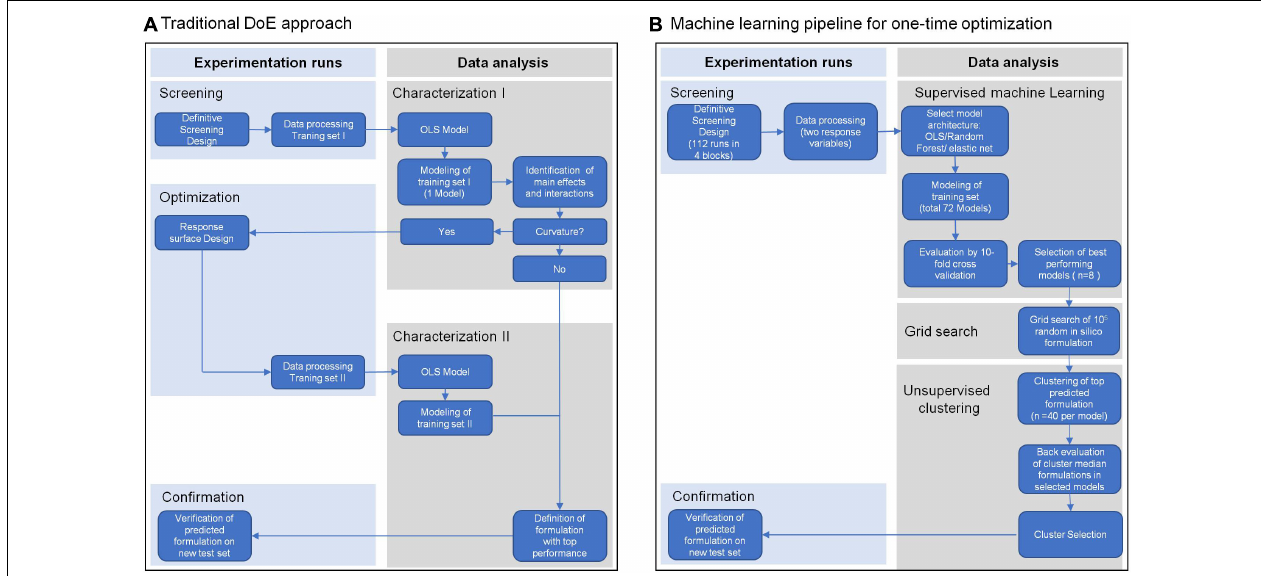
FIGURE 1 | Overview of the traditional Design of Experiment (DoE) approach (A) and of a machine learning pipeline (B) . Both approaches include a screening step for data collection, in this case from expansion of T cells from four different healthy donors in a definitive screening design. Traditional DoE uses interpretable model architectures across all donors such as ordinary least squares regression (OLS) to select significant features (Characterization I). A second experimental step is applied to screen for optimal parameter levels (Optimization II). In a second modeling step using OLS the optimal parameter levels are determined for an optimal media formulation (Characterization II) that is experimentally confirmed (Confirmation). The machine learning pipeline (B) uses competitive machine learning algorithms to generate complex models for every response variable in every donor, which allow high prediction accuracy but are less interpretable (Supervised machine learning). After cross-validation these models are used to select the top 40 media formulations for every donor and every response variable from a random set of 10 5 in silico media formulations (Grid search). The top 40 formulations of all donors and responses are clustered by formulation similarity and a cluster formulation was defined by the median component level of all formulations in a cluster (Unsupervised Clustering). Back evaluation of cluster formulations in the donor models for every response allows selection of the media formulation with the best response across all donors and responses, which again is experimentally confirmed